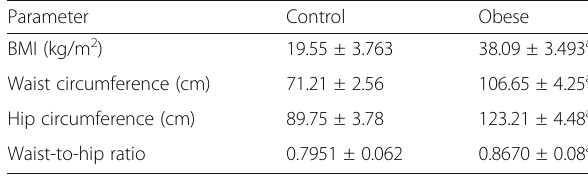
Table 3 Comparison of the anthropometric parameters between control and obese